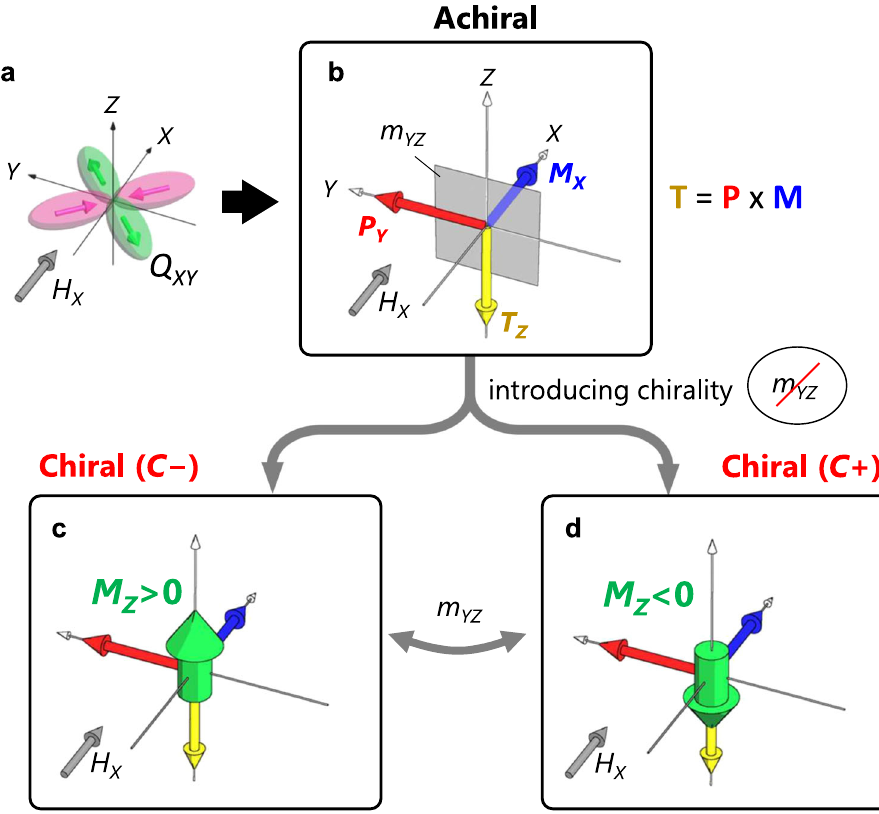
Fig. 1 Conceptual illustration of orthogonal magnetization induced by magnetic quadrupole and chirality. a Schematic illustration of the Q XY -type magnetic quadrupole. In an applied magnetic fi eld along the X axis ( H X ), Q XY produces the electric polarization along the Y axis through the linear magnetoelectric effect. b Directions of H X -induced P Y , the trivial H X -induced magnetization along the X axis ( M X ), and the toroidal moment along the Z axis de fi ned by T = P × M . The system is achiral because the mirror plane parallel to the YZ plane m YZ is present. c , d A pair of chiral systems C − ( c ) and C + ( d ) obtained by breaking the mirror symmetry of m YZ in the achiral system ( b ). They are related by m YZ . Combination of T Z and chirality generates the new Z -axis component of the magnetization ( M Z ) in an applied H X , whose sign is reversed by a chirality switching. This orthogonal magnetization is the subject of this